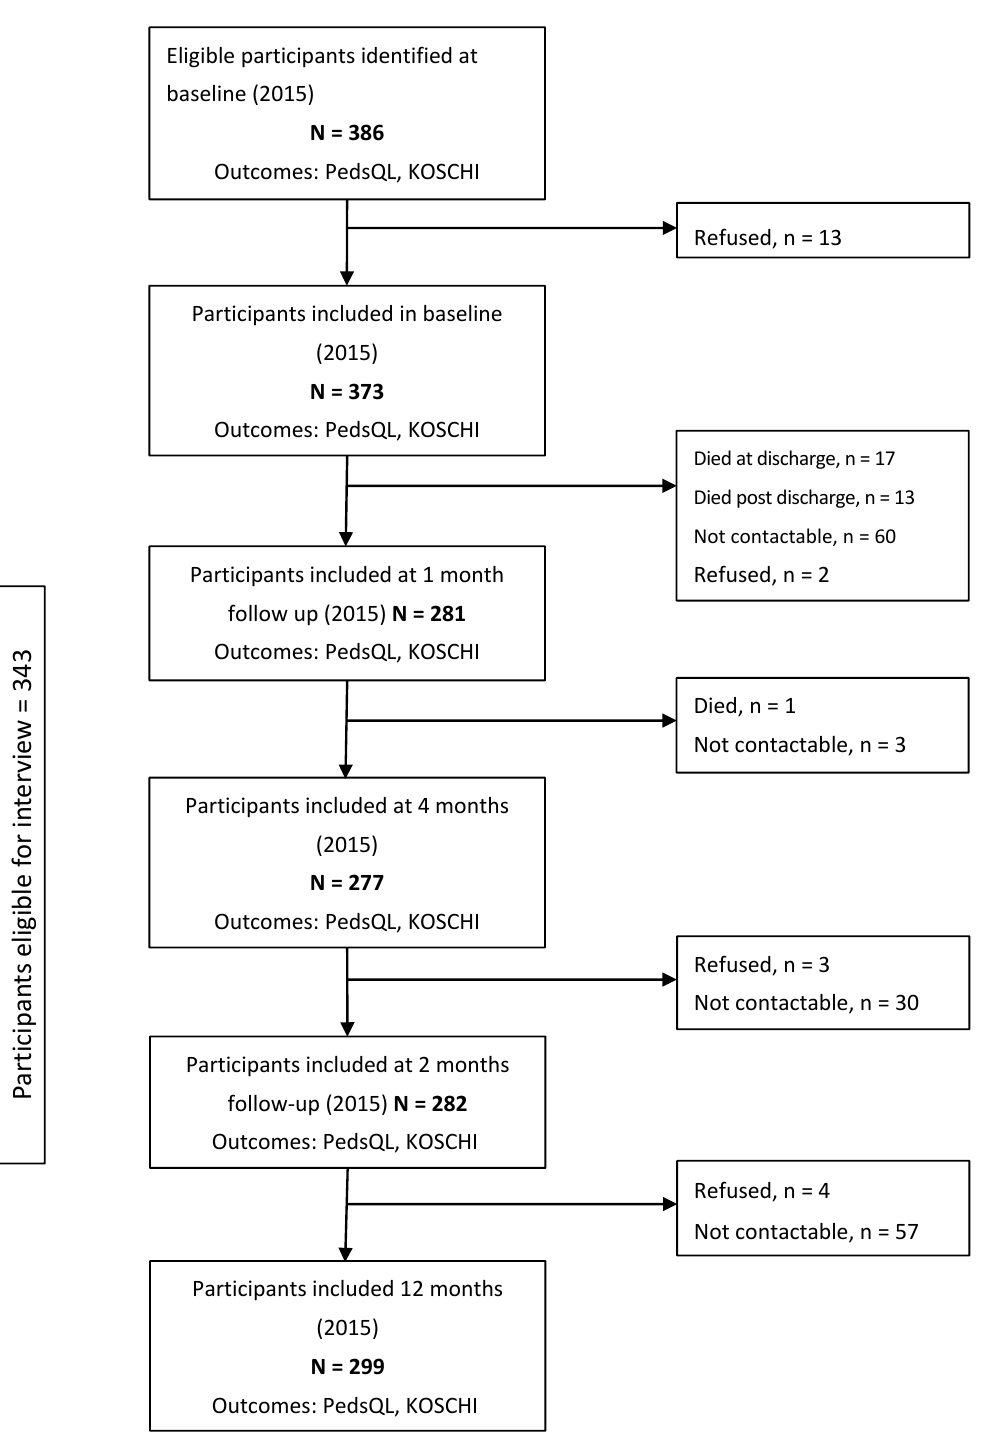
Figure 1. Flow chart of prospective cohort study. PedsQL: Pediatric Quality of Life Inventory; KOSCHI: King’s Outcome Scale for Childhood Head Injury.